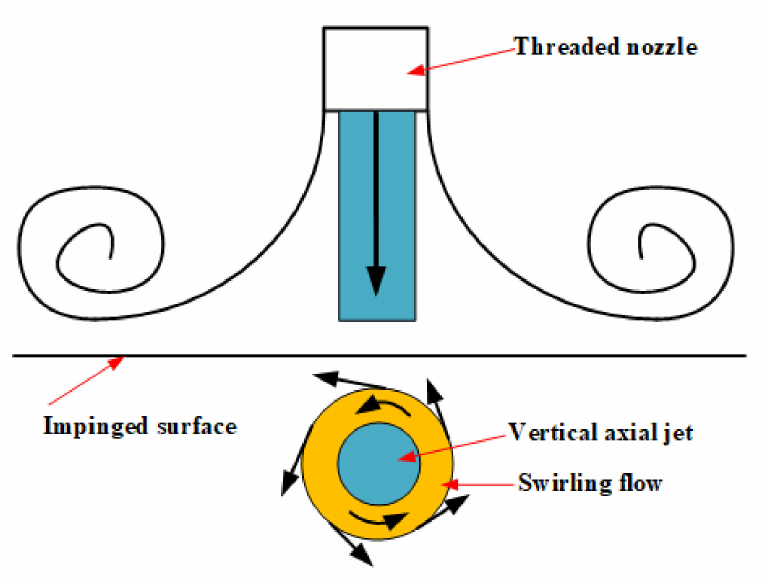
Figure 12. Schematic map for swirling impinging